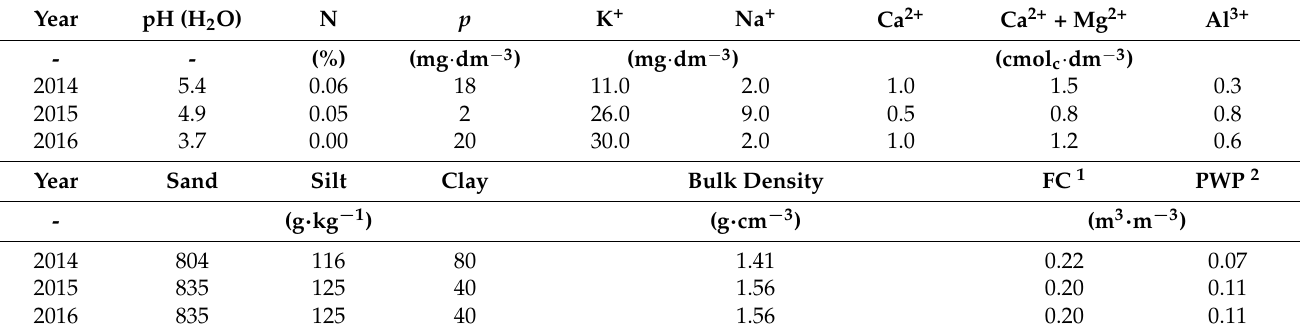
Table 1. Chemical and physical properties of the soil at the experimental